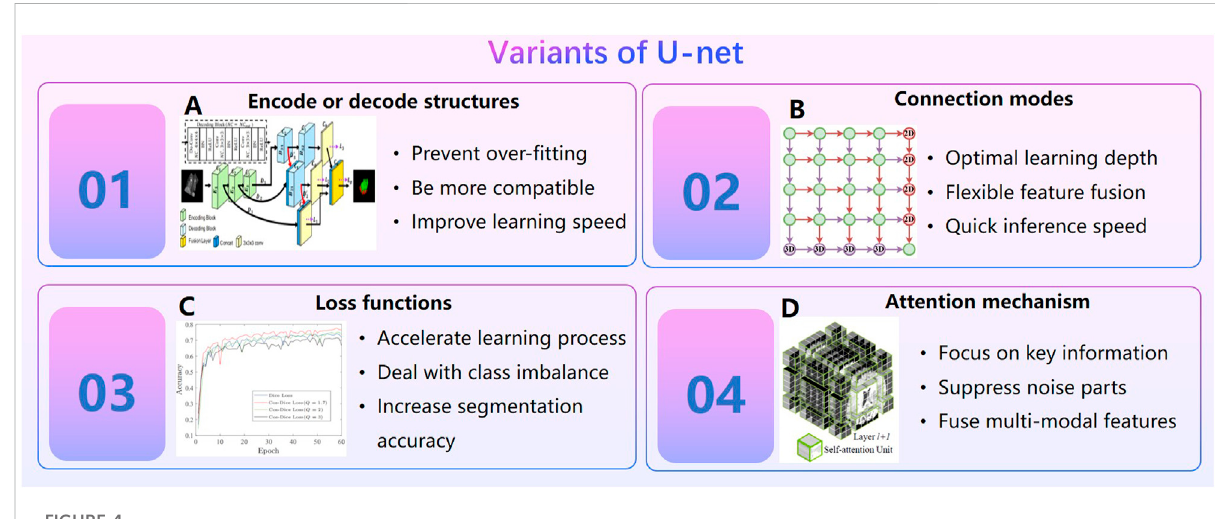
FIGURE 4 Variants of U-net. (A) . Cascade decoder: A Universal Decoding Method for Biomedical Image Segmentation (Liang et al., 2019). (B) . MNet: Rethinking 2D/3D Networks for Anisotropic Medical Image Segmentation (Dong et al., 2022). (C) . A Novel Focal Tversky loss function with improved Attention U-Net for lesion segmentation (Abraham and Khan, 2018). (D) . Swin UNETR: Swin Transformers for Semantic Segmentation of Brain Tumors in MRI